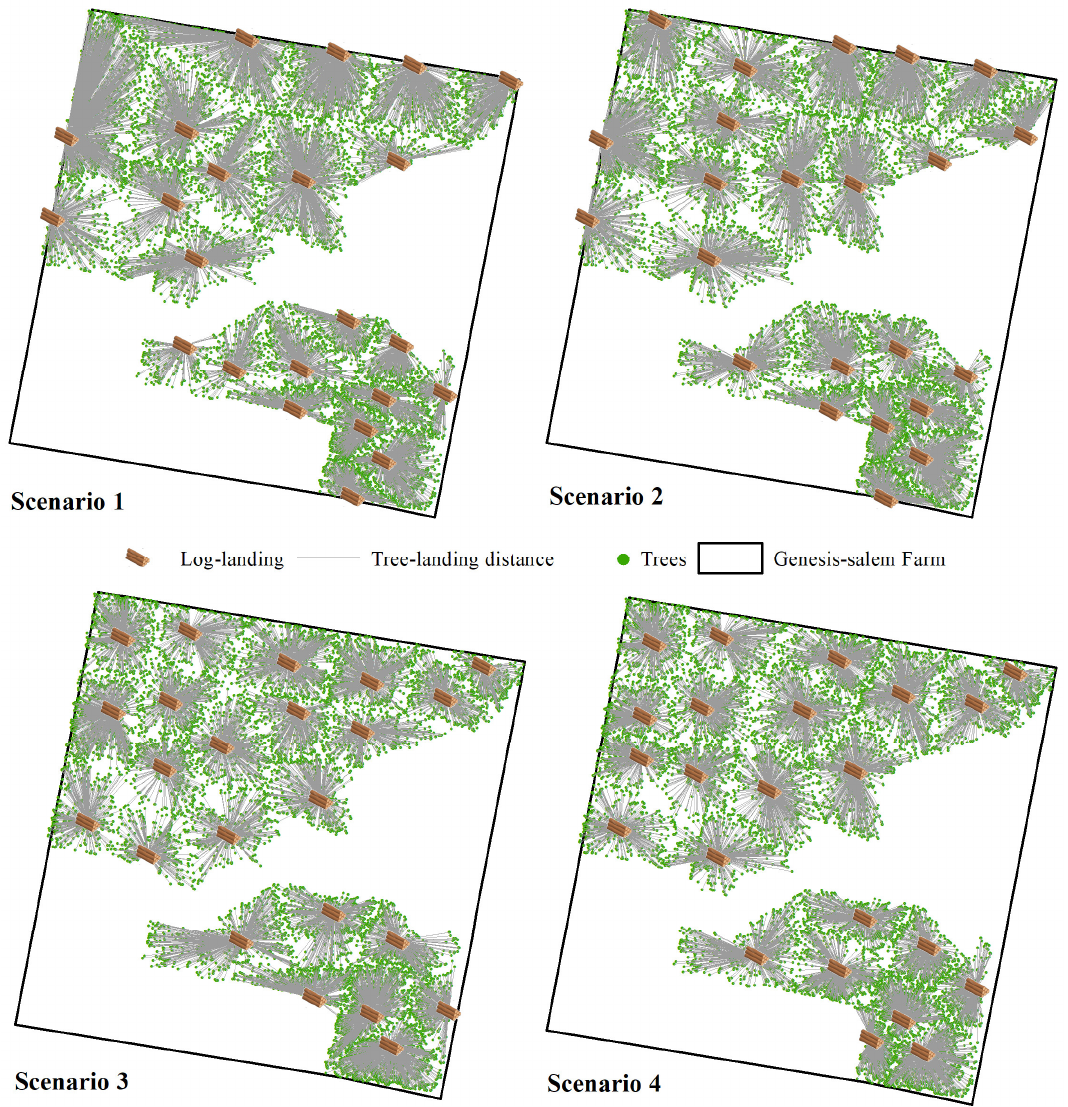
Figure 7. Results of tree-yard optimization scenarios. Lines represent the target yard for each tree (skidding routes follow network setting according to Figure S1), stacked logs represent yard locations and green points represent trees for harvesting.